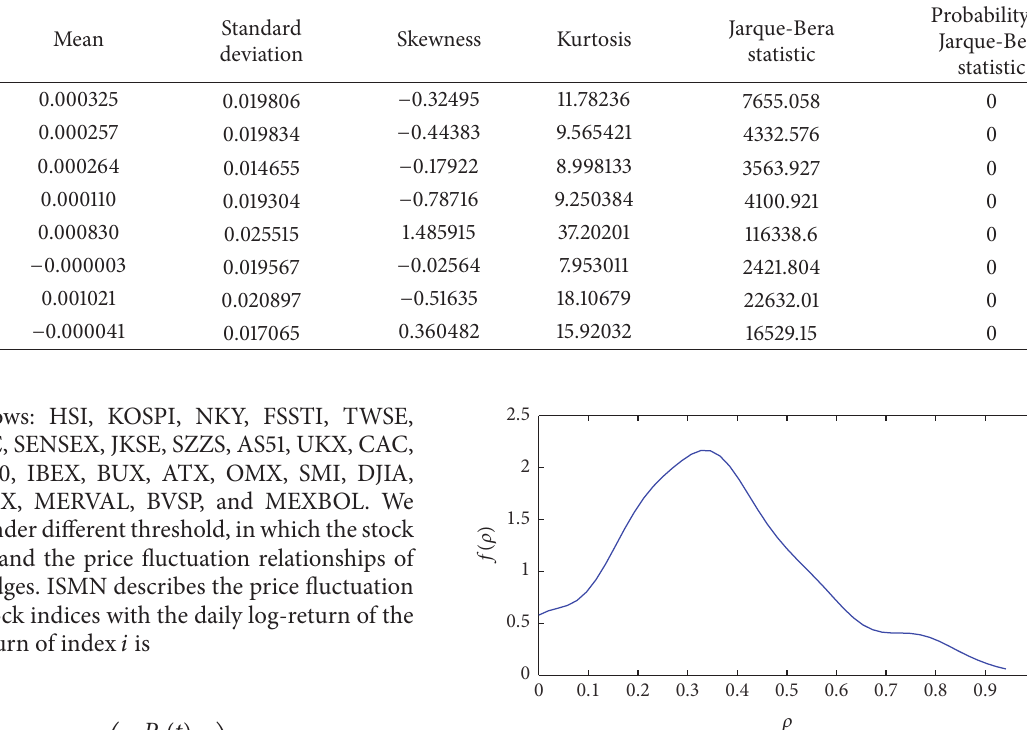
Table 1: The basic statistical properties of 27 index nodes’ yield data sets.